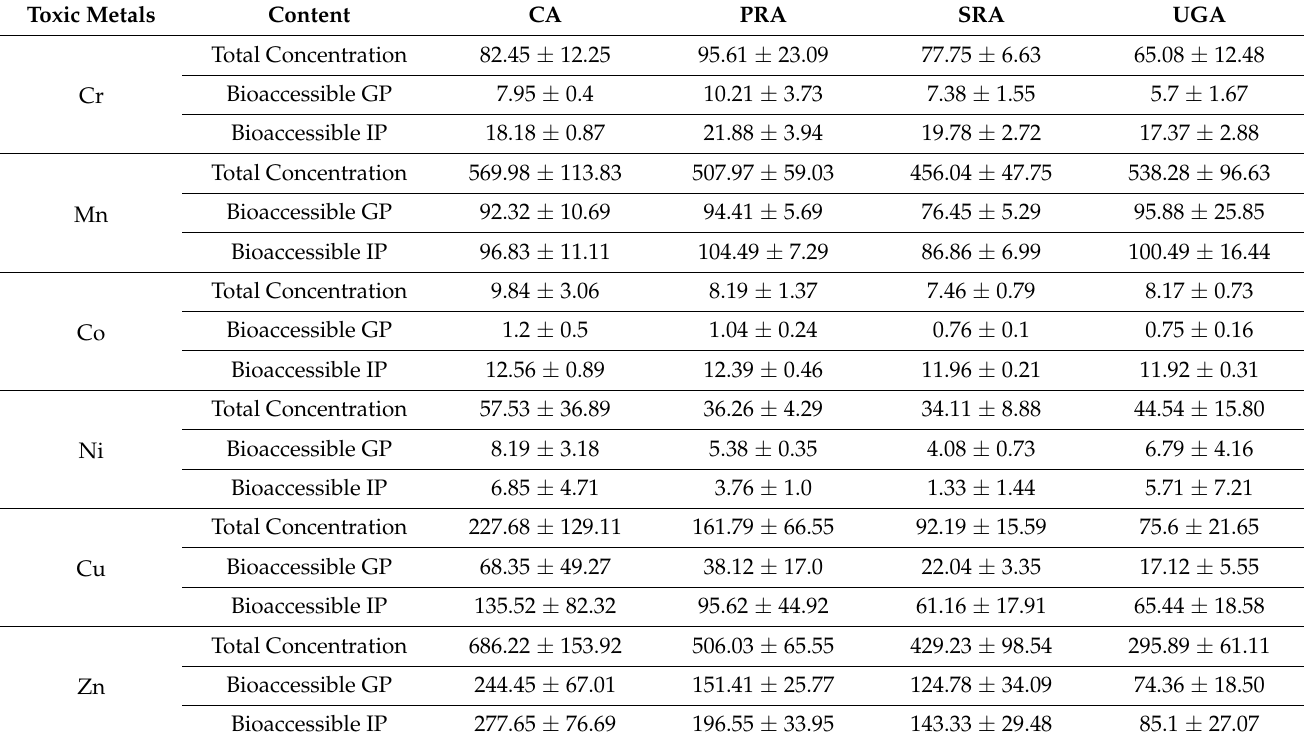
Table 2. Concentrations of toxic metals and their bioaccessible amounts in different land categories ( µ g/g) in Dhaka city. (CA = commercial area, PRA = planned residential area, SRA = spontaneous residential area, UGA = urban green